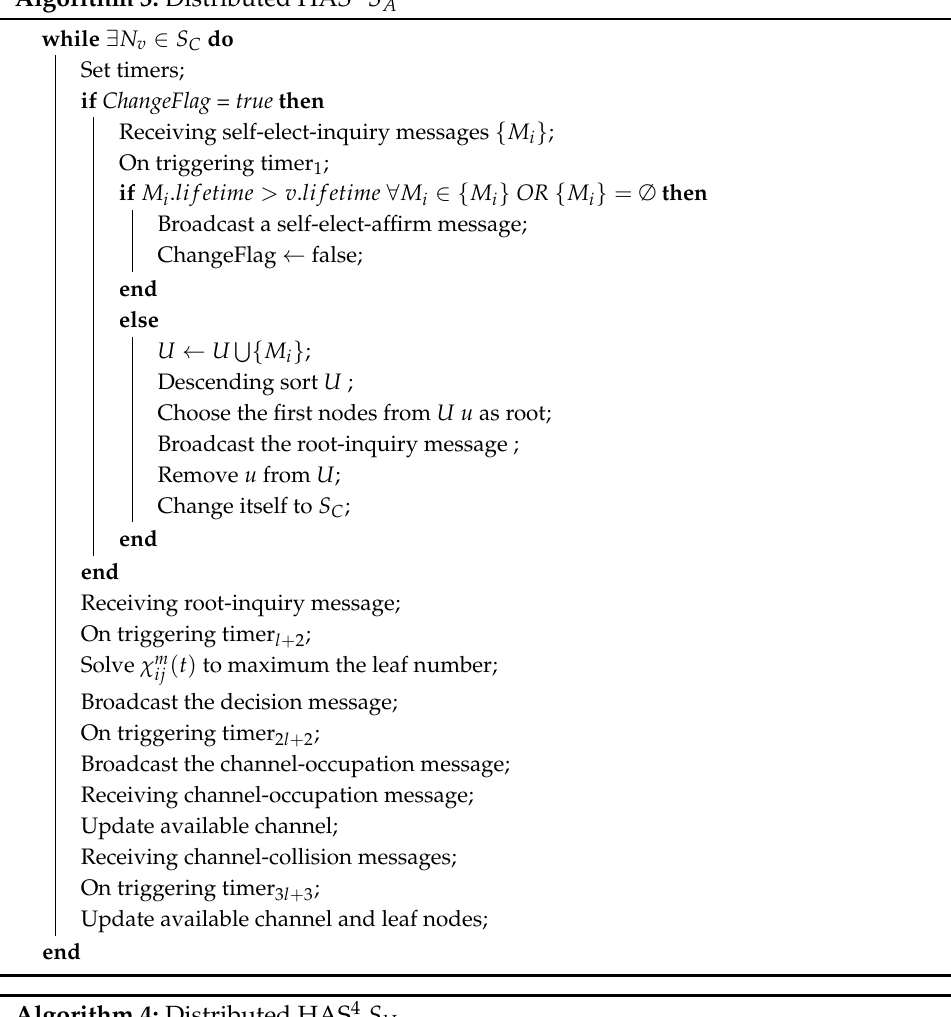
Algorithm 3: Distributed HAS 4 S A